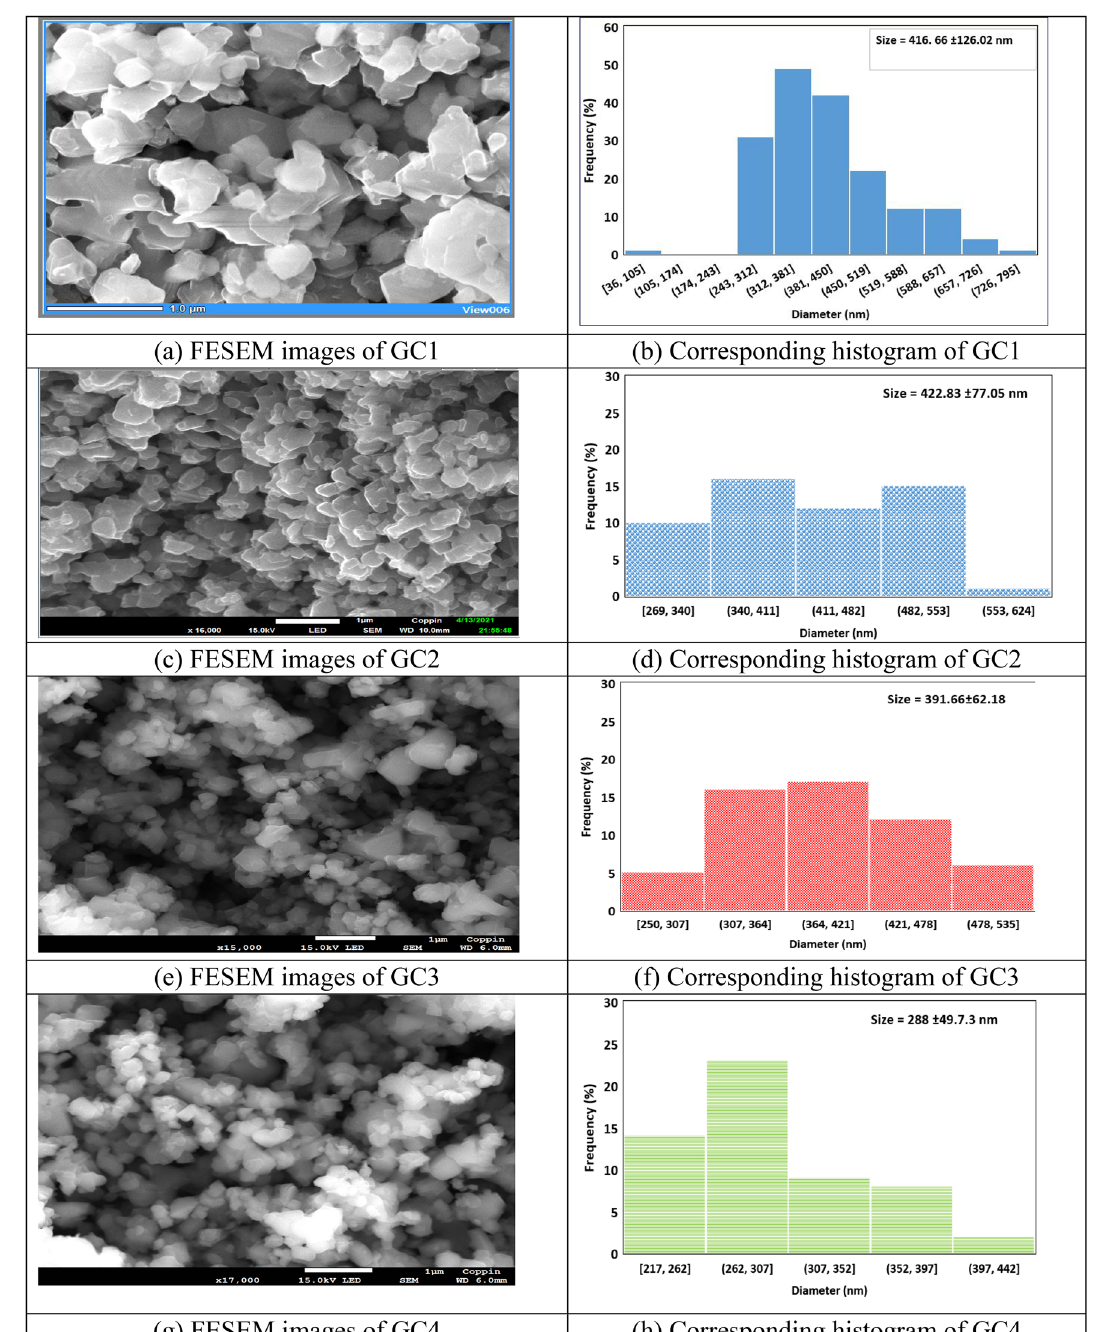
Fig. 4 FESEM images and corresponding histogram of the prepared LTO